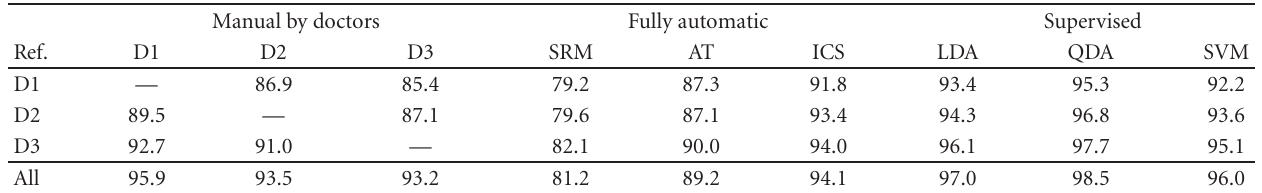
Table 1: Average accuracy of segmentation, quantified by the sensitivity (%), showing the performance of the proposed ICS method against alternative solutions. Borders manually drawn by three dermatologists, and their agreement, are considered as the ground-truth reference for accuracy assessment.